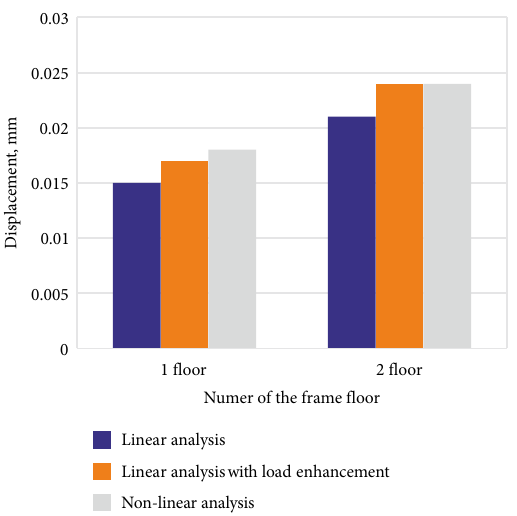
Figure 4. Comparison of different types of analysis of